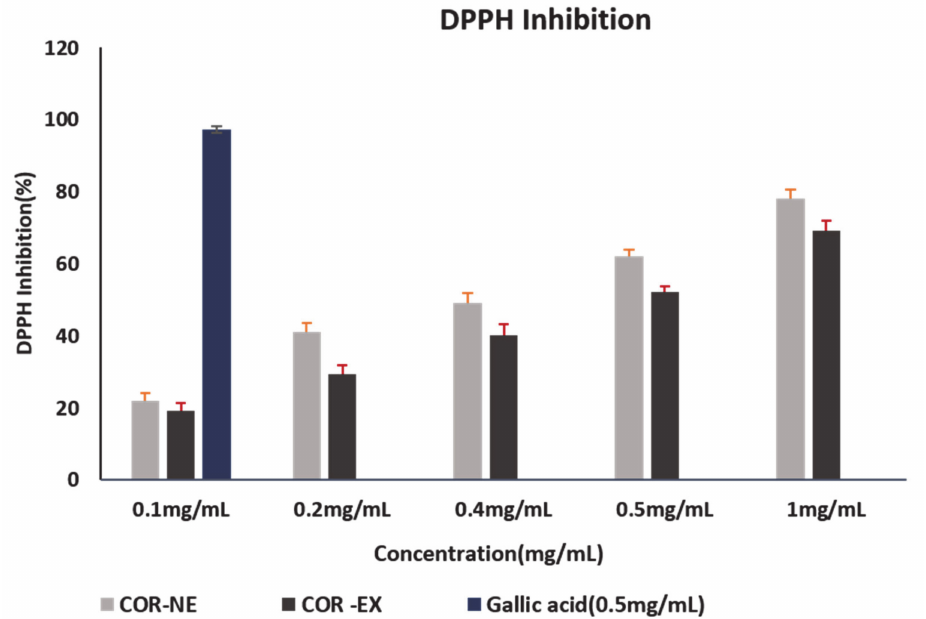
Figure 4. Antioxidant properties of Cordyceps nanoemulsion compared with commercial antioxidant agent Gallic acid using DPPH inhibition